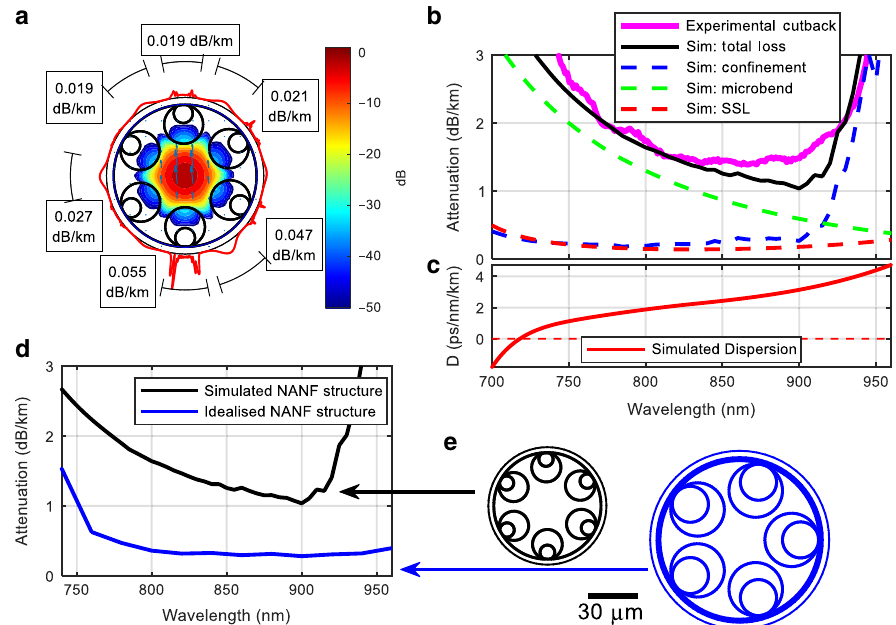
Fig. 4 Simulation results of NANF-B . a Fundamental mode at 850 nm with contours of longitudinal Poynting vector, and azimuthally resolved power leakage (radial Poynting vector) is visualised as a red external curve - local regions of high leakage are highlighted and quanti fi ed in the labels. b Measured fi bre loss compared with total simulated loss (black) as the sum of the con fi nement loss (blue), surface scattering (red), and microbend (green) losses. c Group velocity dispersion of the simulated structure. d The total loss of the simulated NANF-B (black) compared with an idealised 5-tube structure (blue), depicted to scale in e